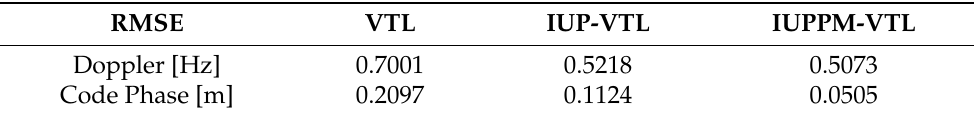
Figure 10. Code phase error of the 10th-Pseudilite. Table 2. Comparision of doppler and code phase errors of the